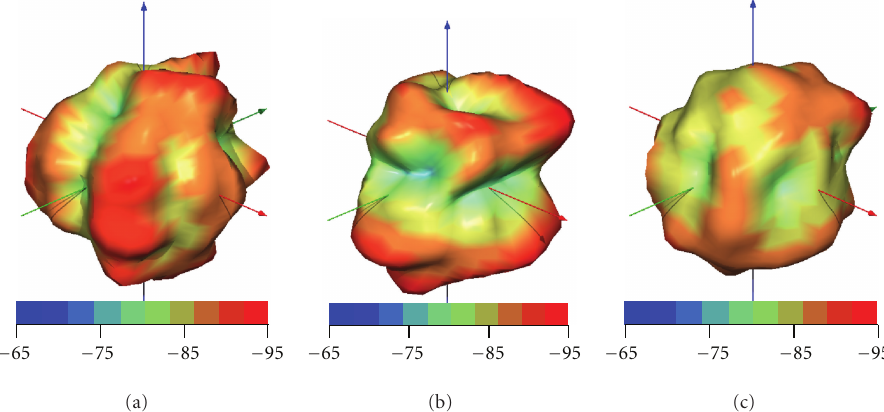
Figure 3: 3D sensitivity pattern (dBm) of an HSDPA dongle: (a) ϕ polarised DL signal only, (b) ϑ polarized DL signal only, (c) decorrelated copies of the DL signal with half power each on either polarization.